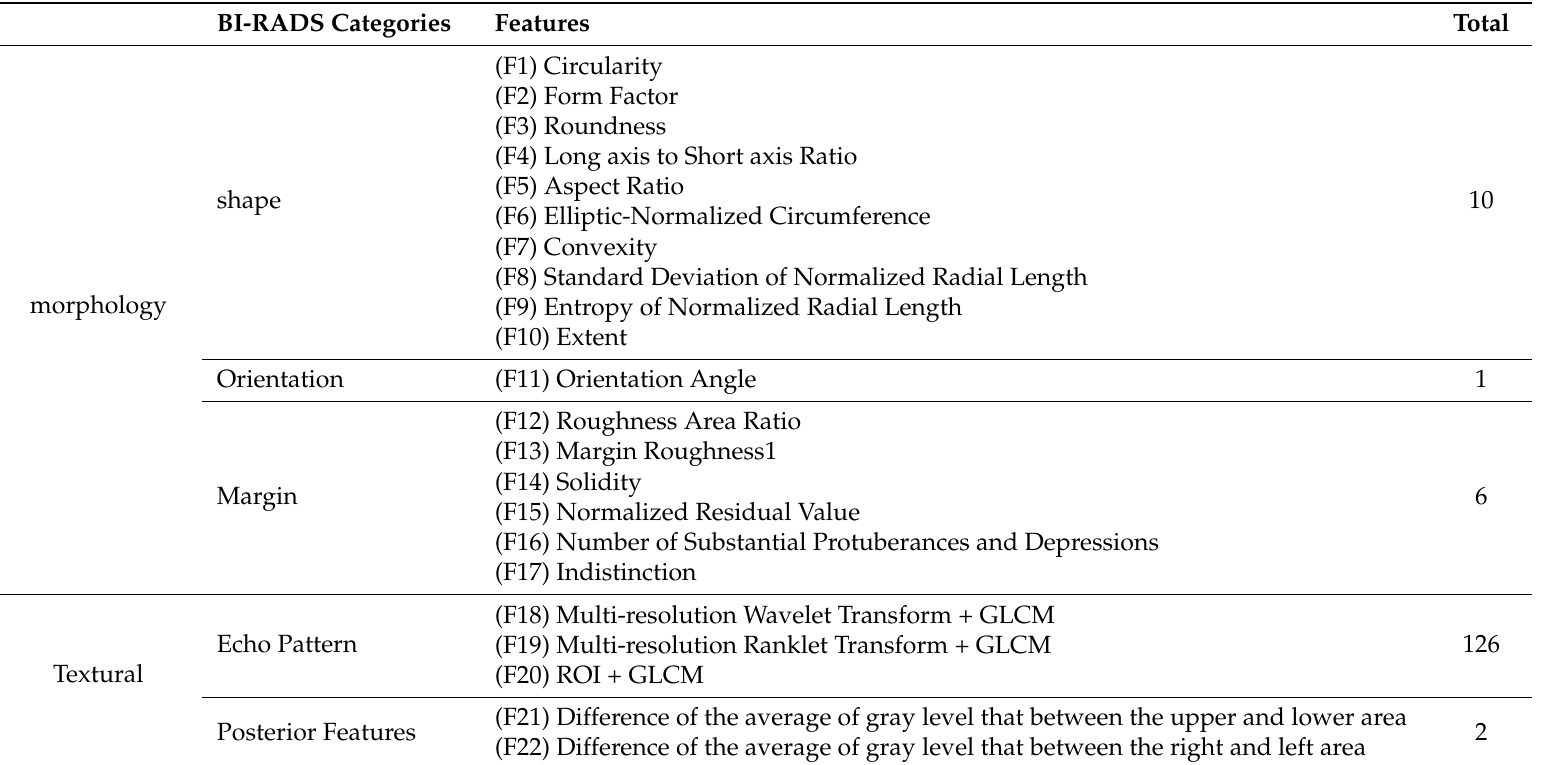
Table 4. BI-RADS features corresponding